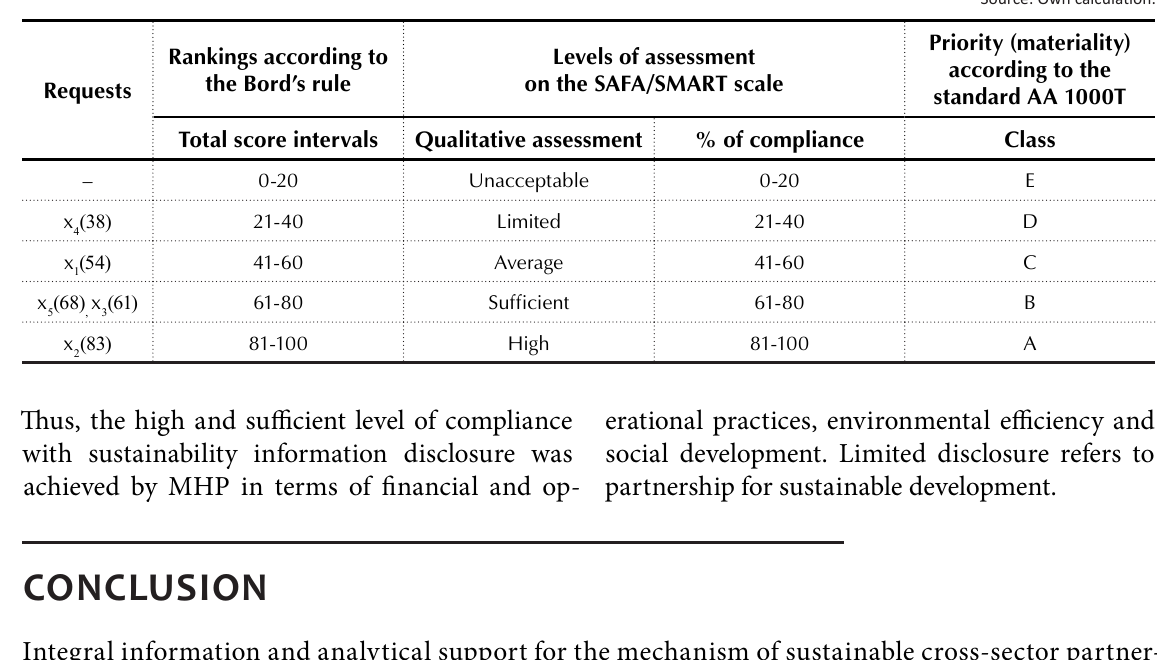
Table 6. Interpretation of the ranking of information requests of the MHP in 2016